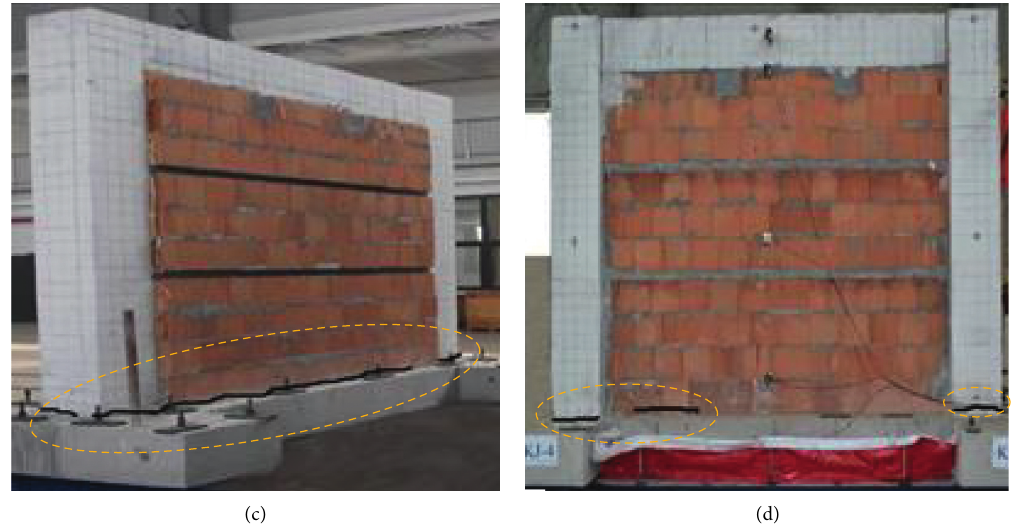
Figure 8: Condition of walls at the conclusion of testing. (a) W-1. (b) W-2. (c) W-3. (d)